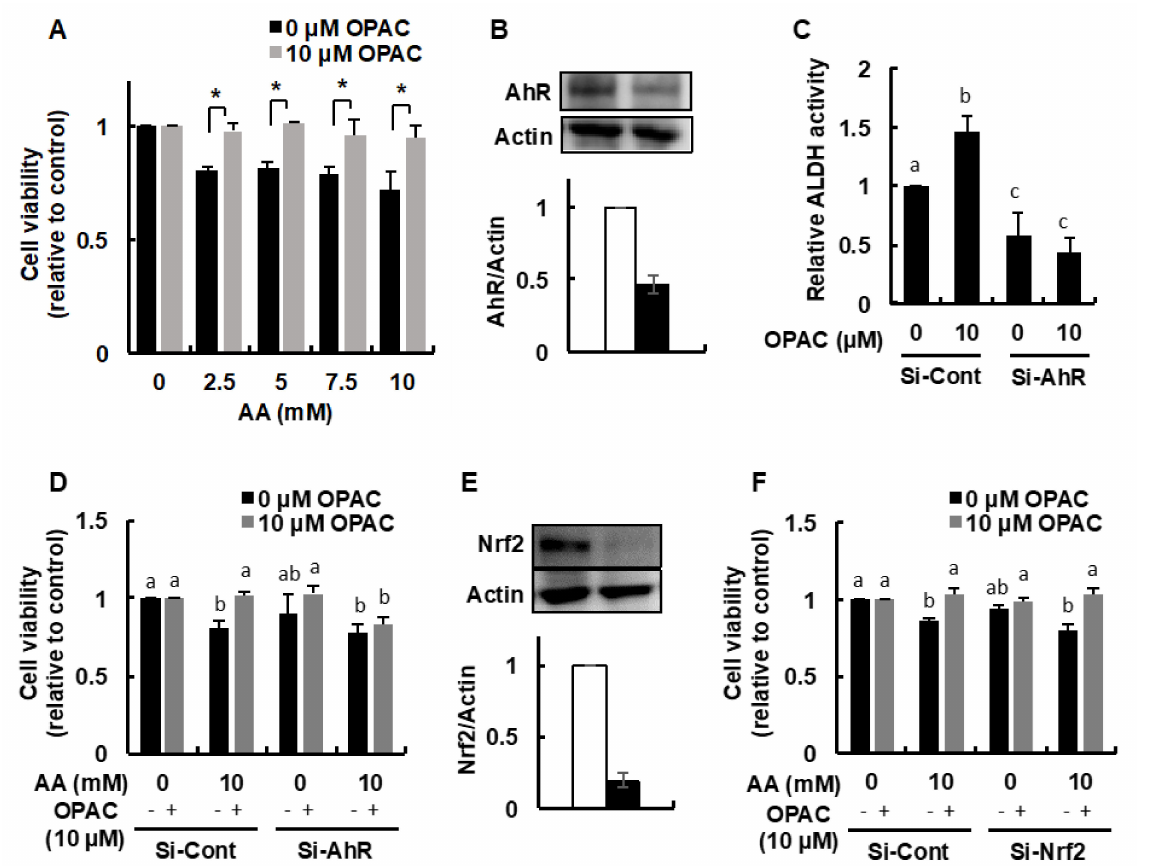
Figure 5. AhR-dependent protection against the acetaldehyde-induced cytotoxicity by OPAC. ( A ) Inhibitory effect of OPAC pretreatment on the acetaldehyde-induced cytotoxicity. After Hepa1c1c7 cells were pretreated with OPAC for 6 h, the cells were treated with different concentra- tions of acetaldehyde for 3 h; then, an MTT assay was carried out. ( B ) Modulating effect of AhR siRNA on the AhR protein level in the whole cell lysates. Hepa1c1c7 cells were transfected with the AhR siRNA or control scrambled siRNA, then incubated for 48 h. The total cell lysates were subjected to a Western blot analysis ( n = 2). ( C ) Modulating effect of AhR siRNA on the total ALDH activity. The Hepa1c1c7 cells transfected with the AhR siRNA or control scrambled siRNA were treated with OPAC for 6 h, and the total ALDH activity was determined by a microplate reader (340 nm). ( D ) Impairment of the OPAC-enhanced resistance to the acetaldehyde-induced cytotoxicity by the AhR siRNA. After the Hepa1c1c7 cells transfected with siRNA were pretreated with OPAC for 6 h, the cells were treated with different concentrations of acetaldehyde for 3 h; then, an MTT assay was carried out. ( E ) Modulating effect of Nrf2 siRNA on the Nrf2 protein level in the whole cell lysates. Hepa1c1c7 cells were transfected with the Nrf2 siRNA or control scrambled siRNA, then incubated for 48 h. The total cell lysates were subjected to a Western blot analysis ( n = 2). ( F ) No significant effect of the Nrf2 siRNA on the OPAC-enhanced resistance to the acetaldehyde-induced cytotoxicity. All values are expressed as means ± SD of three separate experiments and analyzed by a Student’s t -test or a one-way ANOVA, followed by Tukey’s HSD using XLSTAT software. The different letters above the bars indicate significant differences among the treatments for each condition (* p < 0.05 vs.